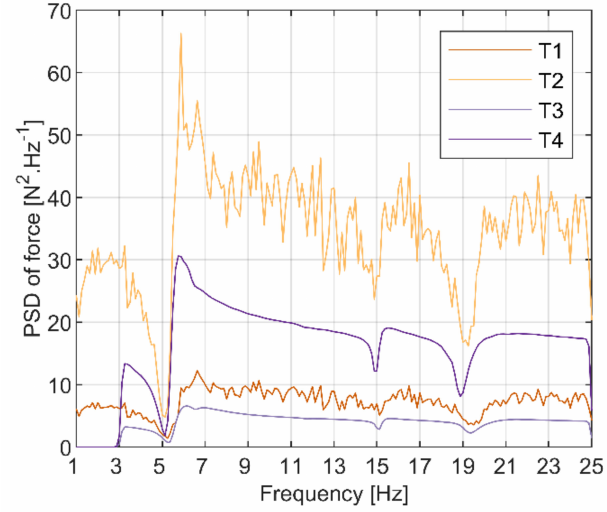
Figure 15. Power spectra density of the input force for all